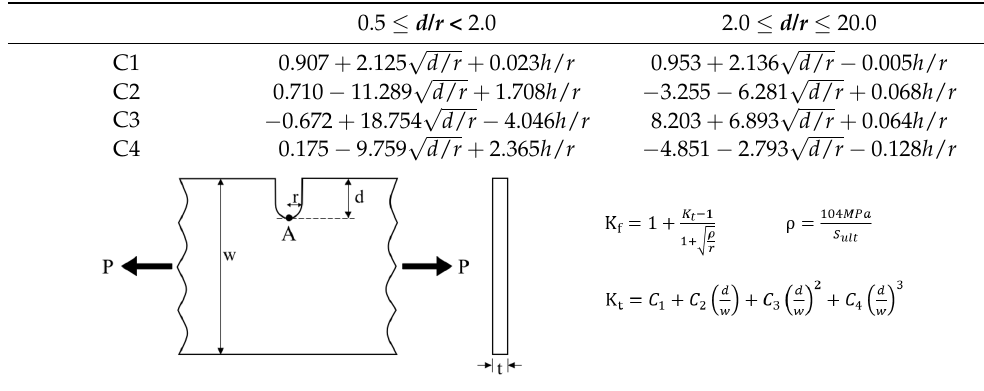
Table 6. Coefficients for the notch stress concentration factor. Data from [13].